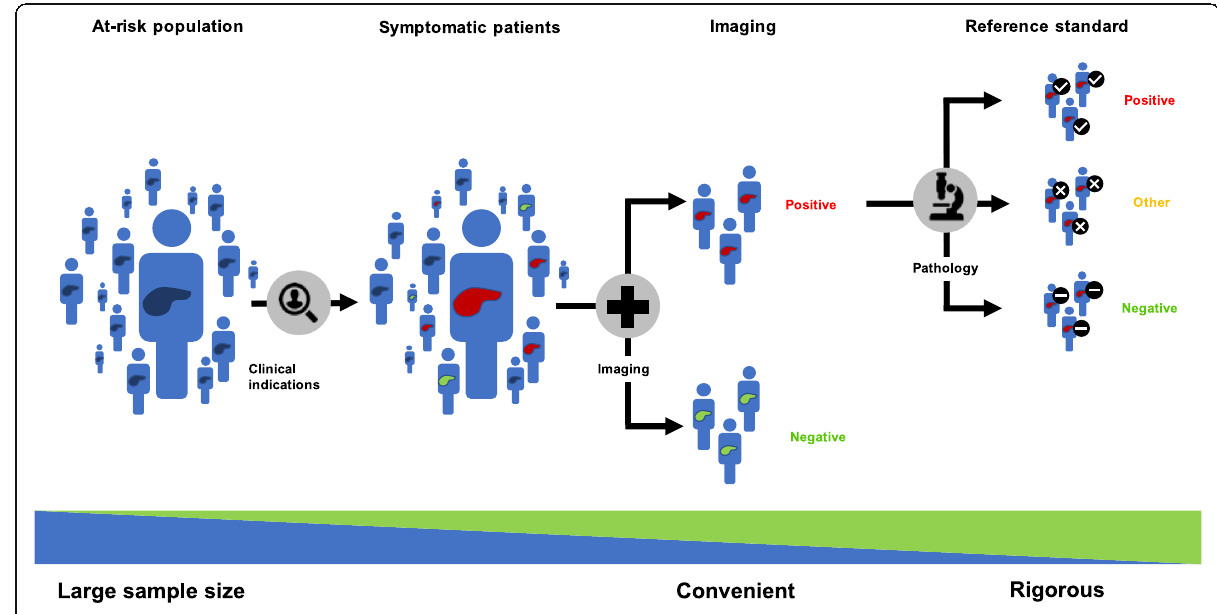
Fig. 3 Concept of case selection based on clinical indication (left), imaging (middle), or pathology (right)